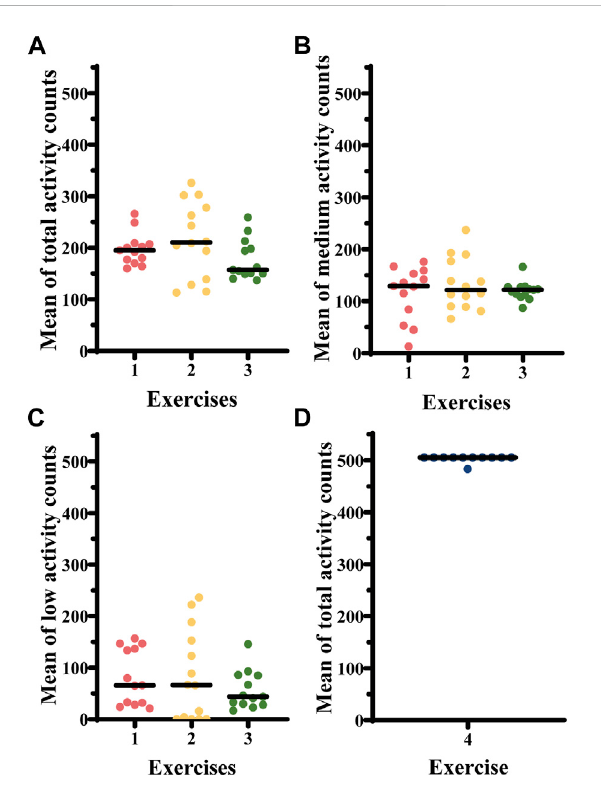
FIGURE 6 (A) Total activity counts, (B) medium activity counts, and (C) low activity counts derived from the accelerometry data for free arm movement exercises 1 – 3 in 14 healthy controls. (D) total activity counts for exercise 4 in 14 healthy controls. Exercise 1 — cherry picking, exercise 2 — little fl yer, exercise 3 — shadow boxing, exercise 4 — hand